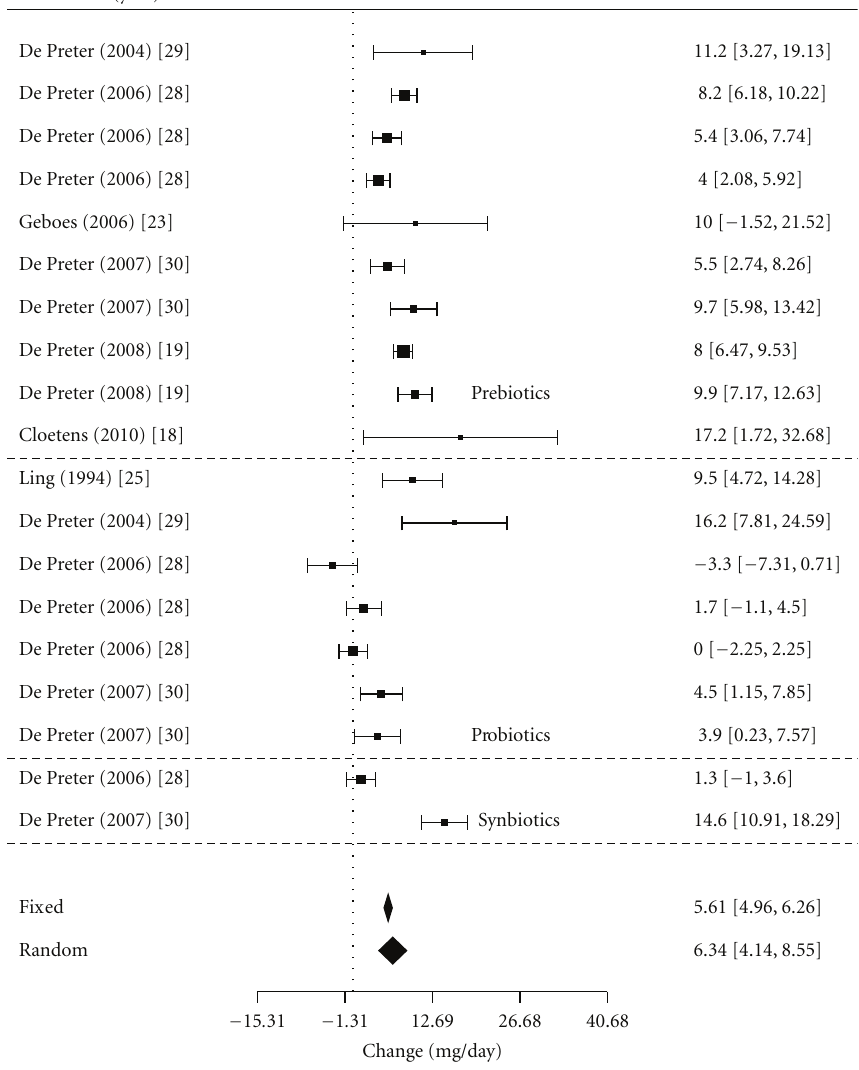
found no e ff ect in pre-, pro-, or synbiotic groups at the end of the four-week supplement period [31]. This negative study found a surprising result where the concentrations of PC, IS, and nearly all fecal parameters increased from week two to week four, for all intervention groups and placebo. This study included some dietary monitoring and reported that there was no significant di ff erence in protein intake that could have explained this